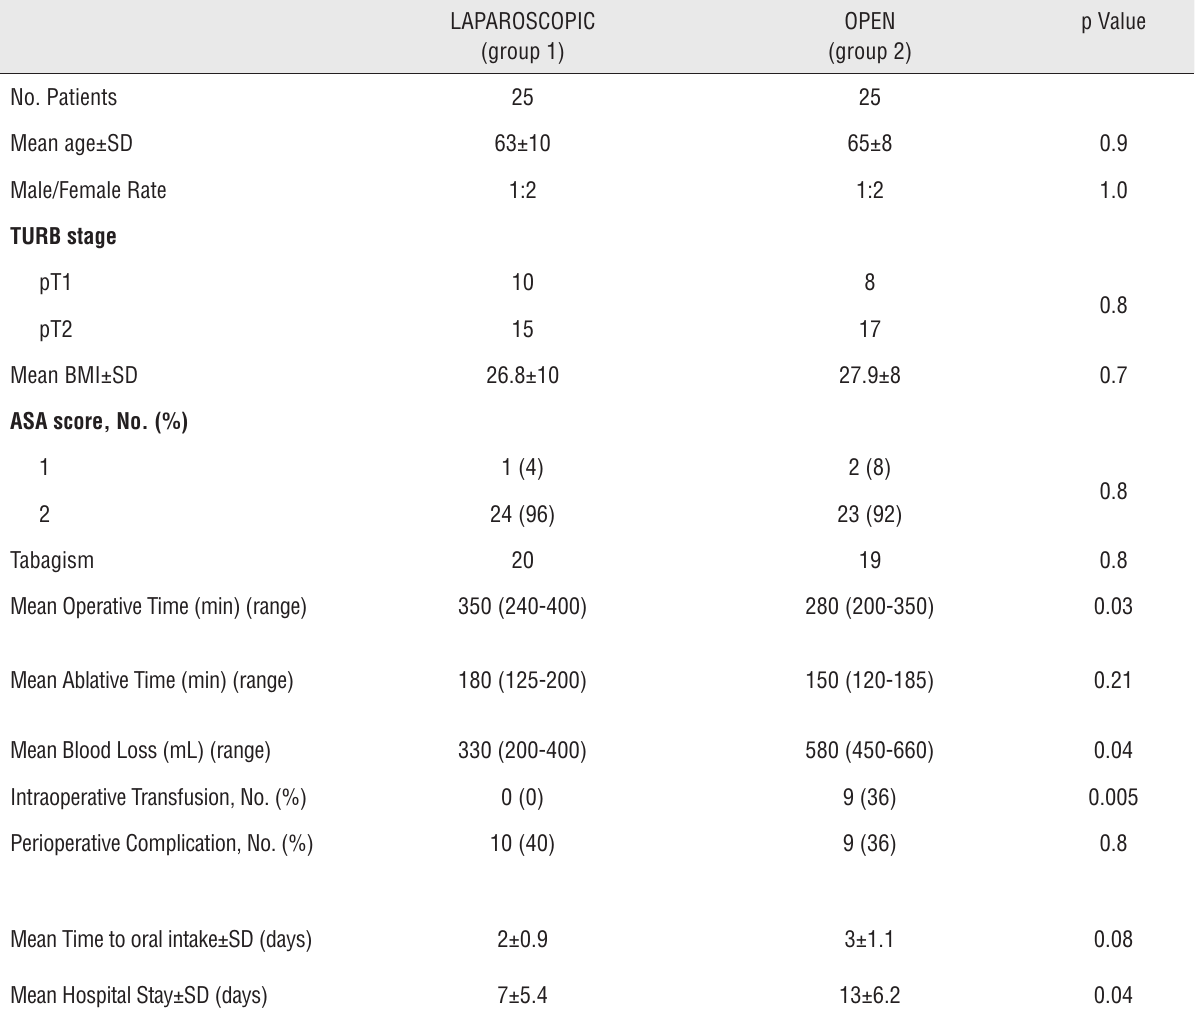
Table 1 - Demographic characteristics and perioperative